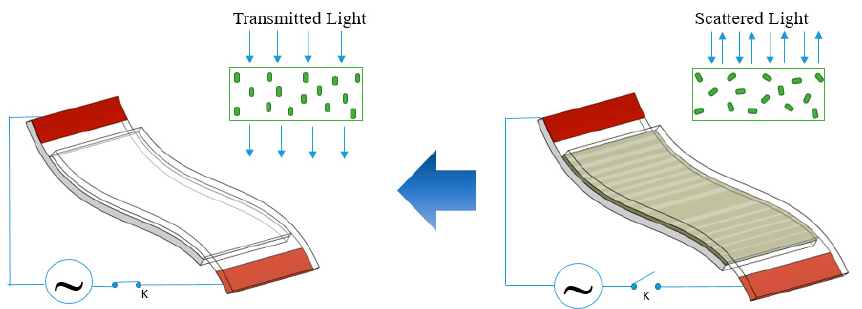
Figure 2. The schematic of the structure and operation of a Cu–Ni NW-based flexible PDLC smart window.